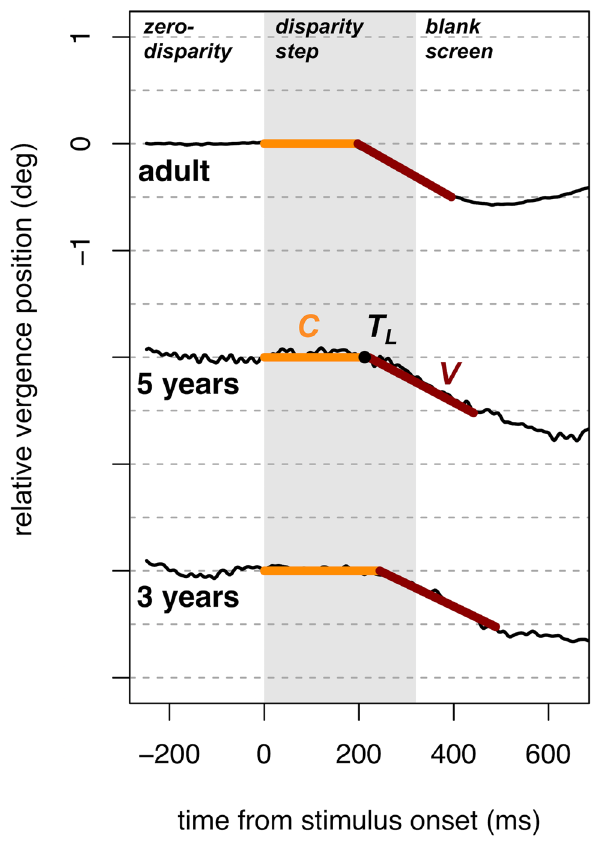
Figure 2. Representative averaged vergence responses collected from one participant in each age group, for stimuli stepped to − 2° disparity (negative disparity indicates a stimulus for convergence). The responses represent the mean vergence position across all trials completed at the relevant disparity (20 trials for the adult and 5-year-old; 10 trials for the 3-year-old). Parameters estimated from the bilinear function are labeled in the middle trace, where C is the stable vergence value for the first zero-disparity period, T L is the latency to the vergence response, and V is the slope representing the summary velocity of the open-loop vergence